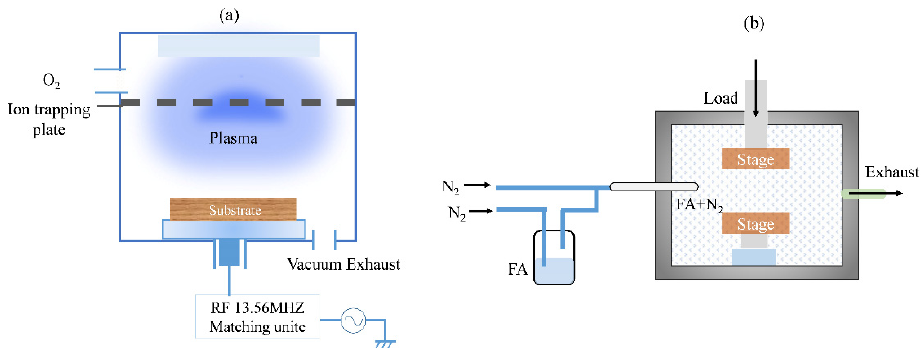
Figure 2. Schematic diagram of the process: ( a ) the plasma activation and the RIE equipment; ( b ) the bonding process under formic acid atmosphere. FA: formic acid.